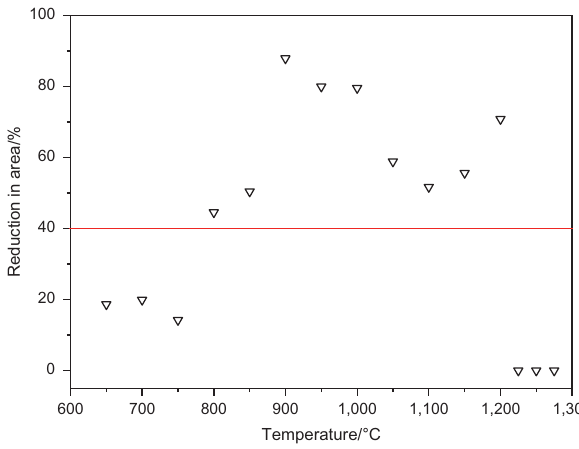
Figure 4: Variation of reduction in area with temperature for TWIP